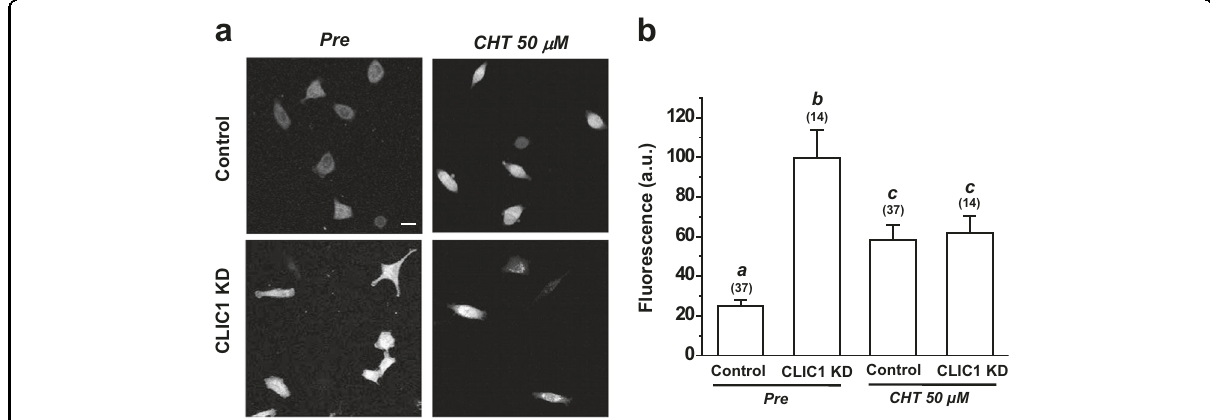
Fig. 2 The basal level of ROS generation was increased in CLIC1-knockdown cells. a Representative images of staining for the ROS marker CM- H2DCFDA in control (upper panel) and CLIC1 KD cells (lower panel) before and after chelerythrine treatment (50 μ M, 10 min). Scale bars, 20 μ m. b CM-H2DCFDA fl uorescence intensity in control and CLIC1 KD cells. The data are the means ± SEMs. The letters indicate statistically distinct groups (ANOVA with Tukey ’ s test, P <